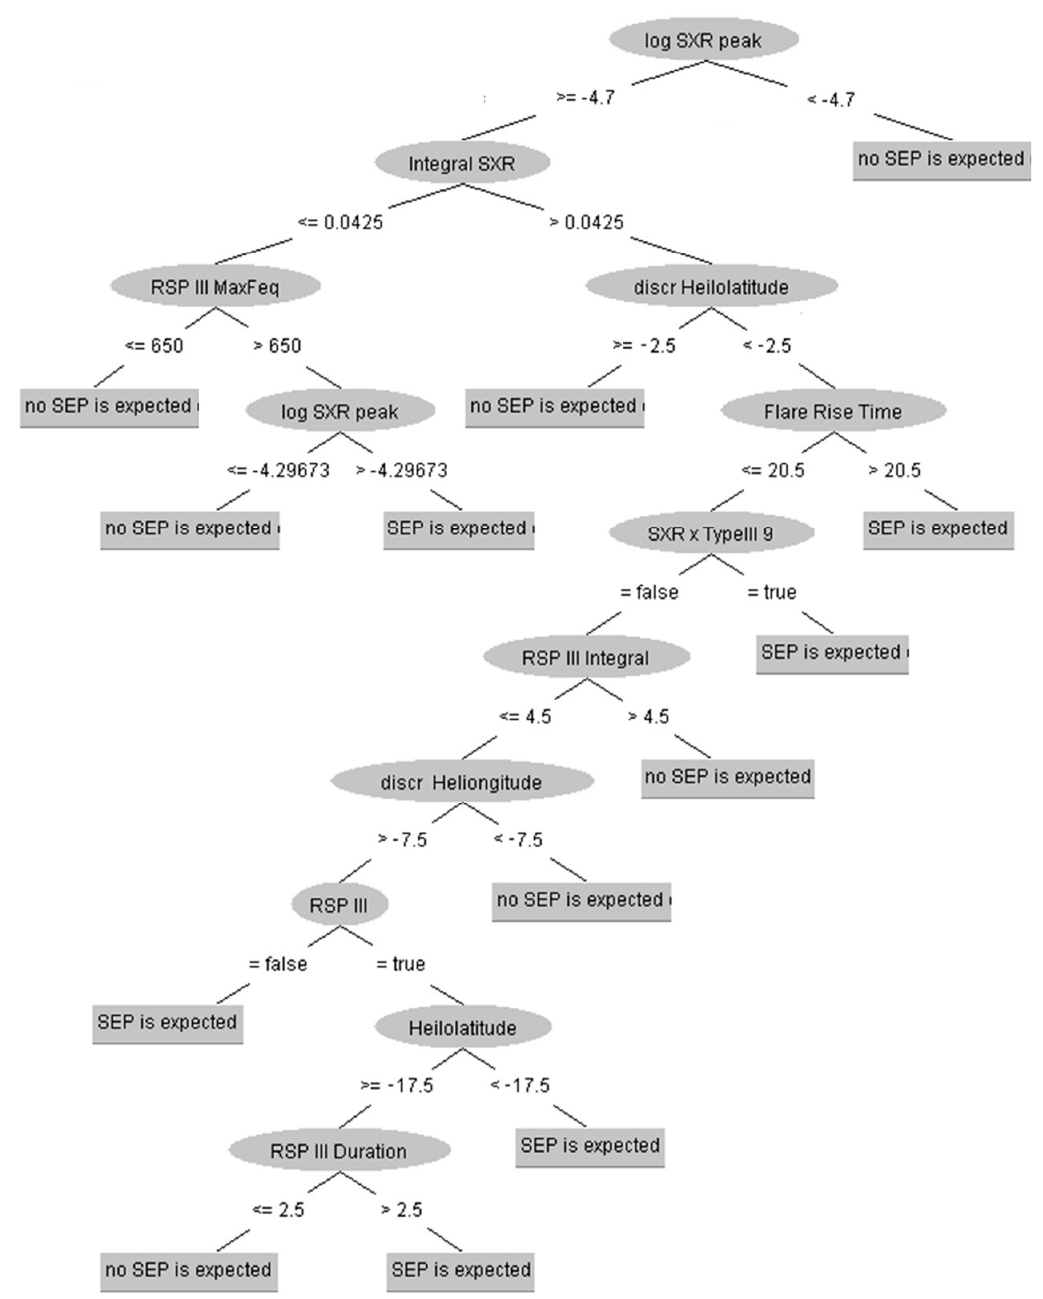
Figure 4. Obtained decision tree.